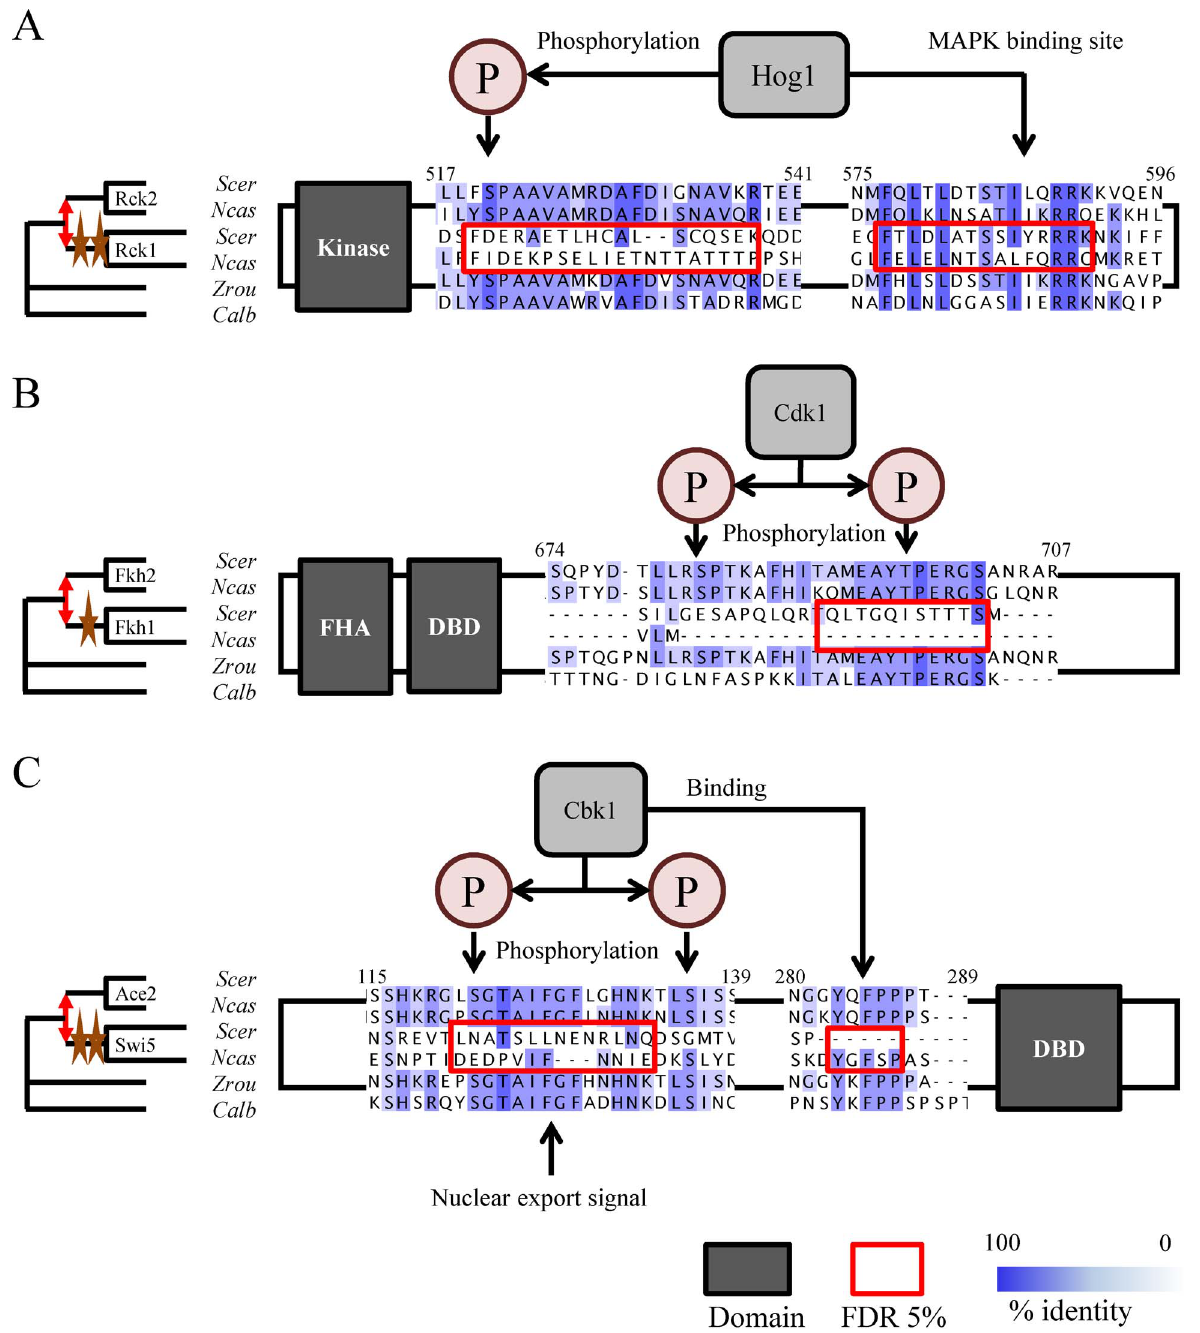
Fig. 4. Examples of known regulatory motifs with changes in constraints. Alignment of the short linear motifs with known function (indicated with arrows) and significant changes in constraints (red boxes) after gene duplication from representative species. A) The Rck2 protein is known to bind and be phosphorylated by Hog1 kinase at two motifs that have significant changes in constraints after gene duplication. Numbers indicate residue position within the S. cerevisiae Rck2 protein. The two identified motifs occur at aa519-538 and aa577-591 for Rck2, and changed constraints within the aligned region aa439-456 and aa492-506 in Rck1. These overlap with the known phosphorylation site in Rck2 (aa520) and the MAP kinase binding site (aa492-506) in Rck2. Both Rck2 and Rck1 retain kinase function. B) The Fkh2 protein is known to be phosphorylated by Cdk1 at two phosphorylation sites on a region shown to have significant changes in constraints after gene duplication. Numbers indicate residue position within the S. cerevisiae Fkh2 protein. The identified motif occurs at region aa692-702 in Fkh2 and has changed constraint in the aligned region aa459- 469 in Fkh1. One of the known phosphorylation site in Fkh2 occurs within this region at aa697. Fkh2 and Fkh1 retain their forkhead-associated domain (FHA) and DNA binding domain (DBD). C) The Ace2 protein is known to bind and be phosphorylated by Cbk1 kinase at two motifs that have significant changes in constraints after gene duplication. Numbers indicate residue position within the S. cerevisiae Ace2 protein. The two identified motifs occur at aa121-134 and aa283-287 in Ace2, and changed constraints within the aligned region aa115-128 and aa247-248 (it is a gap) in Swi5. These overlap with the known phosphorylation site in Ace2 (aa122) and the Cbk1 binding site (aa283-286) in Ace2. Both Ace2 and Swi5 retain their DNA binding domain (DBD). Stars represent significant changes in constraints along the lineage. Red double arrow illustrates the duplication